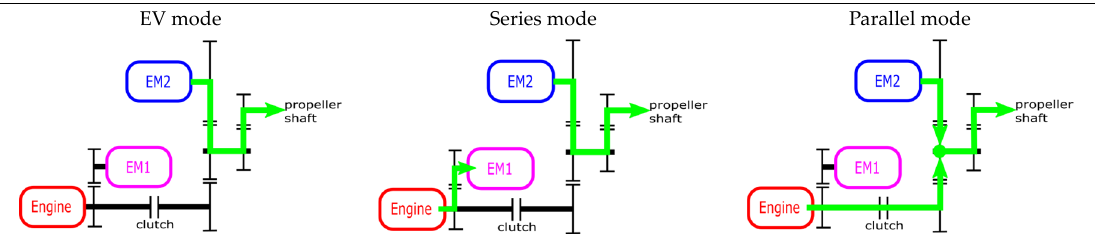
Figure 6. Working modes of the Honda hybrid system.